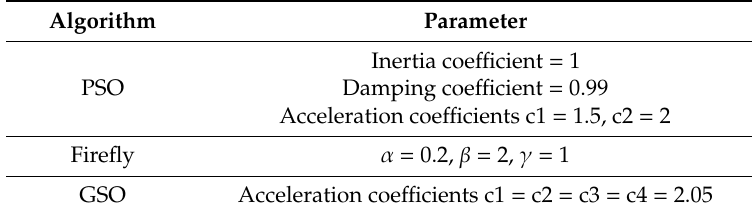
Table 7. Additional parameters for galactic swarm optimization (GSO), PSO and firefly.